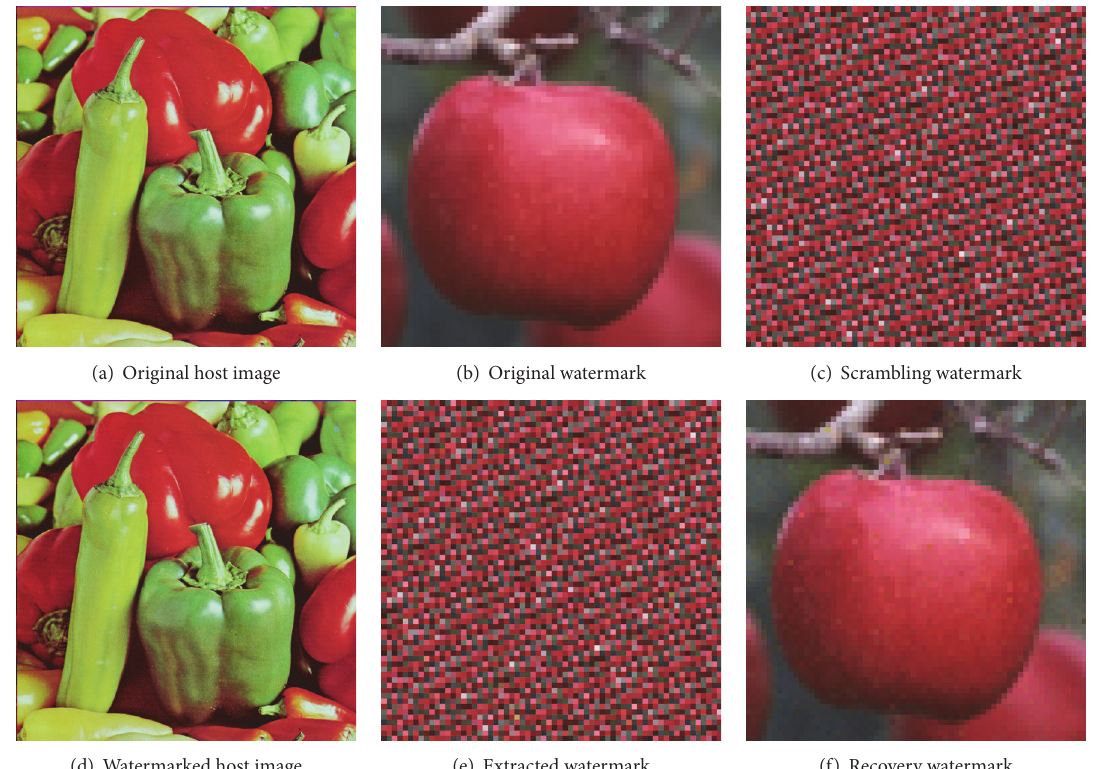
Figure 3: 512 × 512 host image with scale factor